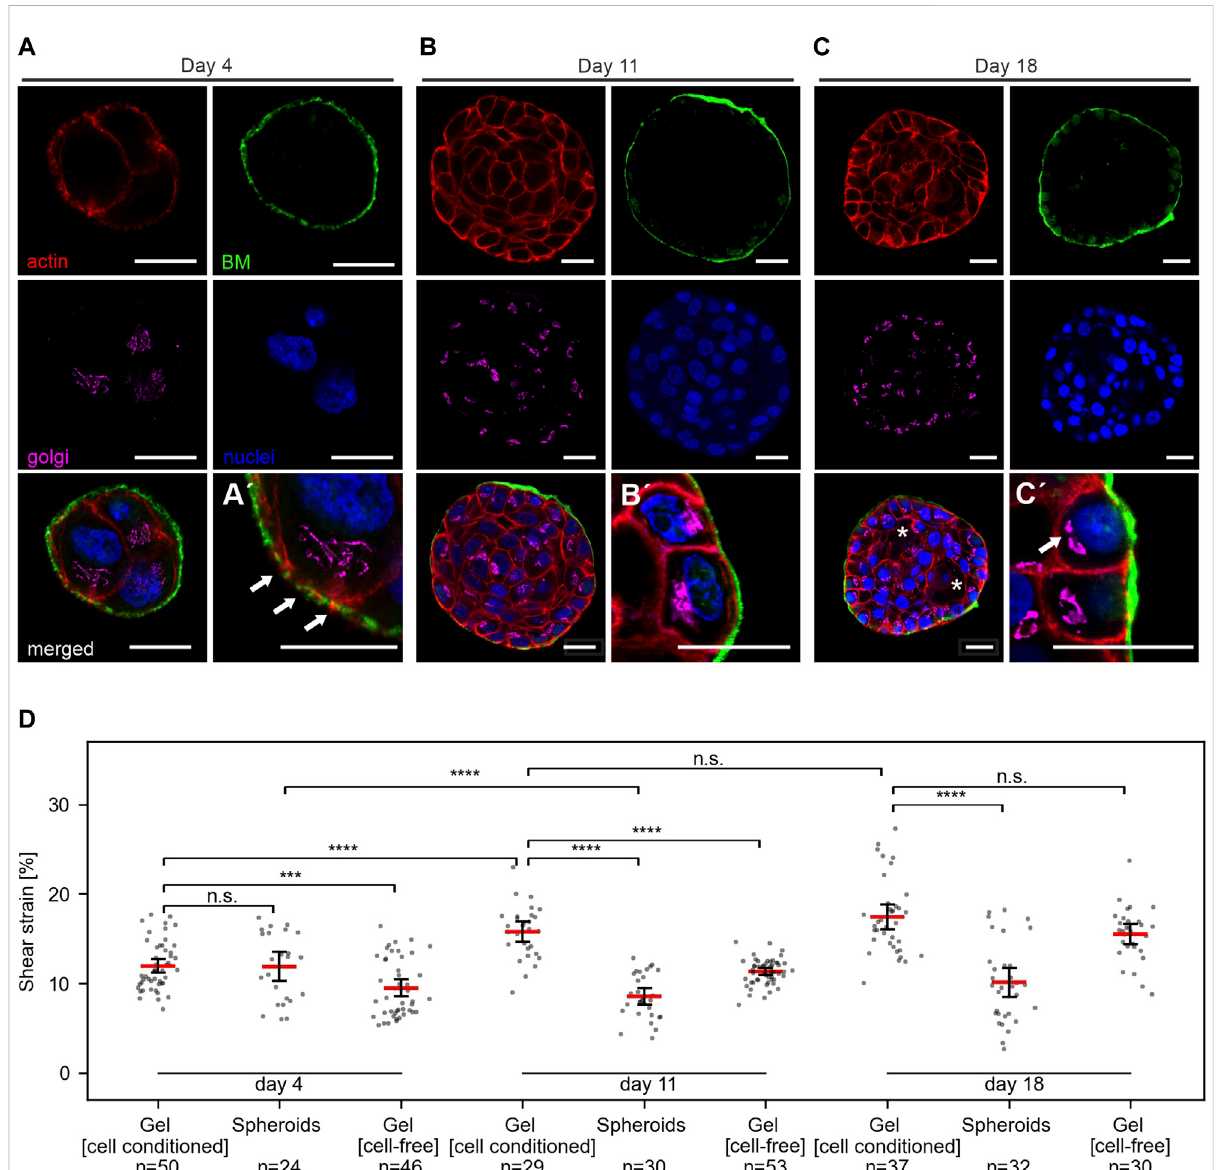
FIGURE 5 Breast spheroids gain shear strain resistance with advanced basoapical polarization. (A – C) Representative micrographs indicate the basoapical polarization process of MCF10A spheroids. Spheroids were cultivated over 4 – 18 days, as described in Figure 3A. Samples were fi xed and IF-stained. Cross-sections at the equatorial plane demonstrate BM formation (collagen type IV, green), the cellular orientation of the Golgi apparatus (GM130, magenta), the actin cytoskeleton (F-actin, red) and cell nuclei (DRAQ-5, blue). Partial lumen clearance was evident on day 18 (white asterisk). Antibody control staining for collagen type IV is provided in Supplementary Figure 1F. (A 9 ) Magni fi cation highlights BM formation and thin collagen penetrating actin protrusions. (B 9 ) Magni fi cation highlights BM maturation and partial apical Golgi orientation. (C 9 ) Magni fi cation highlights a high degree of basoapically polarization. (D) Scatter plots summarize the applied shear strain on hydrogels (pure) MCF-10A spheroids with different maturation stages, hydrogels populated by spheroids (cell-conditioned) and cell-free hydrogels. Strain was measured at 5 mm sled displacement. N = total number of measured positions for three individual gels. Scatter plots: bars: median with 95% con fi dence interval.